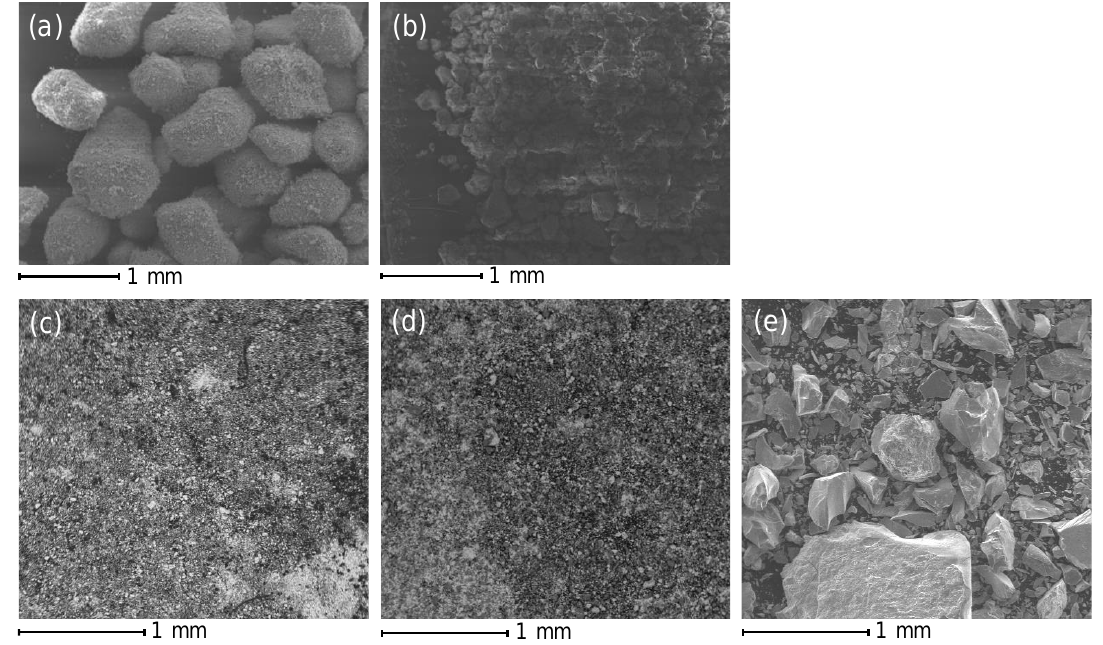
Figure 3. SEM images: ( a ) NiCo_1, ( b ) NiCo_2, ( c ) NiCo_W10%, ( d ) NiCo_W30%, and ( e ) NiCoAl_C.